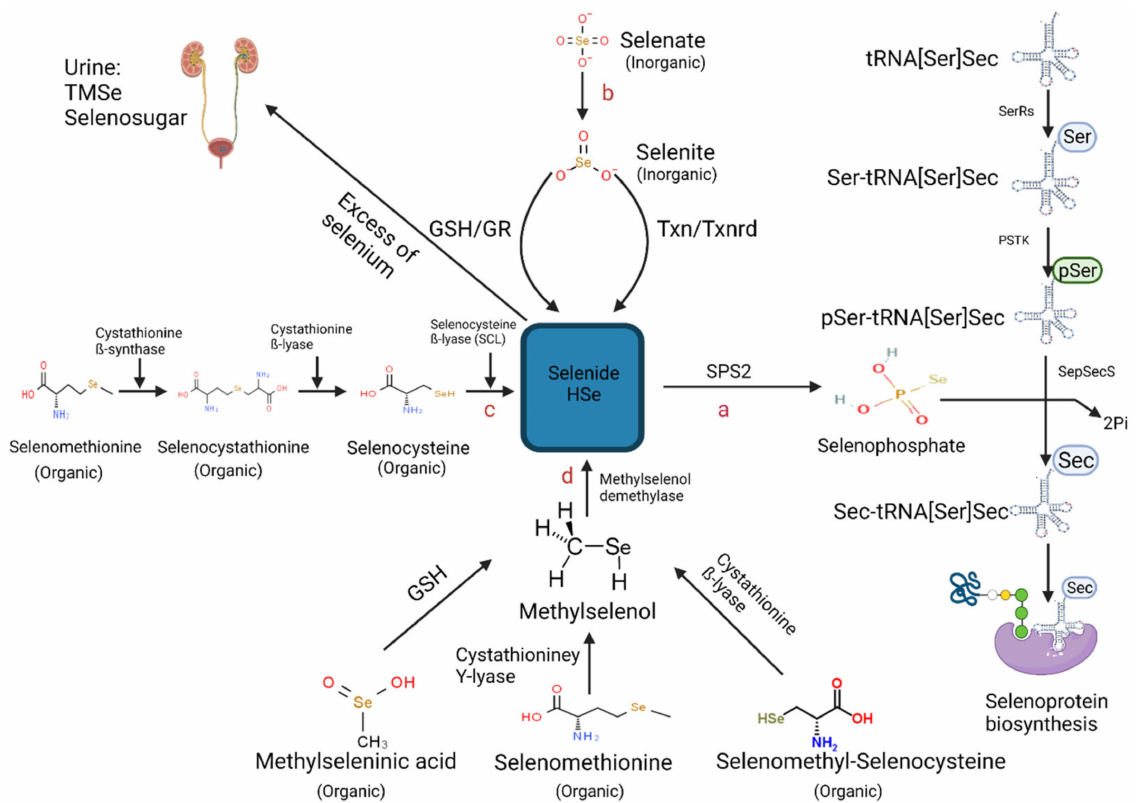
Figure 1. Schematic representation of the known metabolic pathways contributing to selenoprotein biosynthesis [52] (Created with BioRender.com (2021)). Pathways include ( a ) Aminoacylation of Selenocysteine–tRNA[Ser]Sec, ( b ) Chemical reduction of selenite into selenide by either the thioredoxin/thioredoxin reductase (TXN/TXNRD) system or of the glu- tathione peroxidase redox (GSH/GR) system ( c ) Catalyzation of selenomethionine-derived selenocysteine by three enzymes: cystathionine ß-synthase, cystathionine ß-lyase and selenocysteine ß-lyase (SCL) ( d ) Demethylation reaction of methylselenol (CH 3 Se) catalyzed by methylselenol demethylase. Abbreviations includes: (SPS2) selenophosphate 2 synthetase 2, (SerRS) seryl-tRNA synthetase, (PSKT) phosphoseryl-tRNA kinase, (SepSecS) Sec synthase, (TMSe) trimethylselenonium